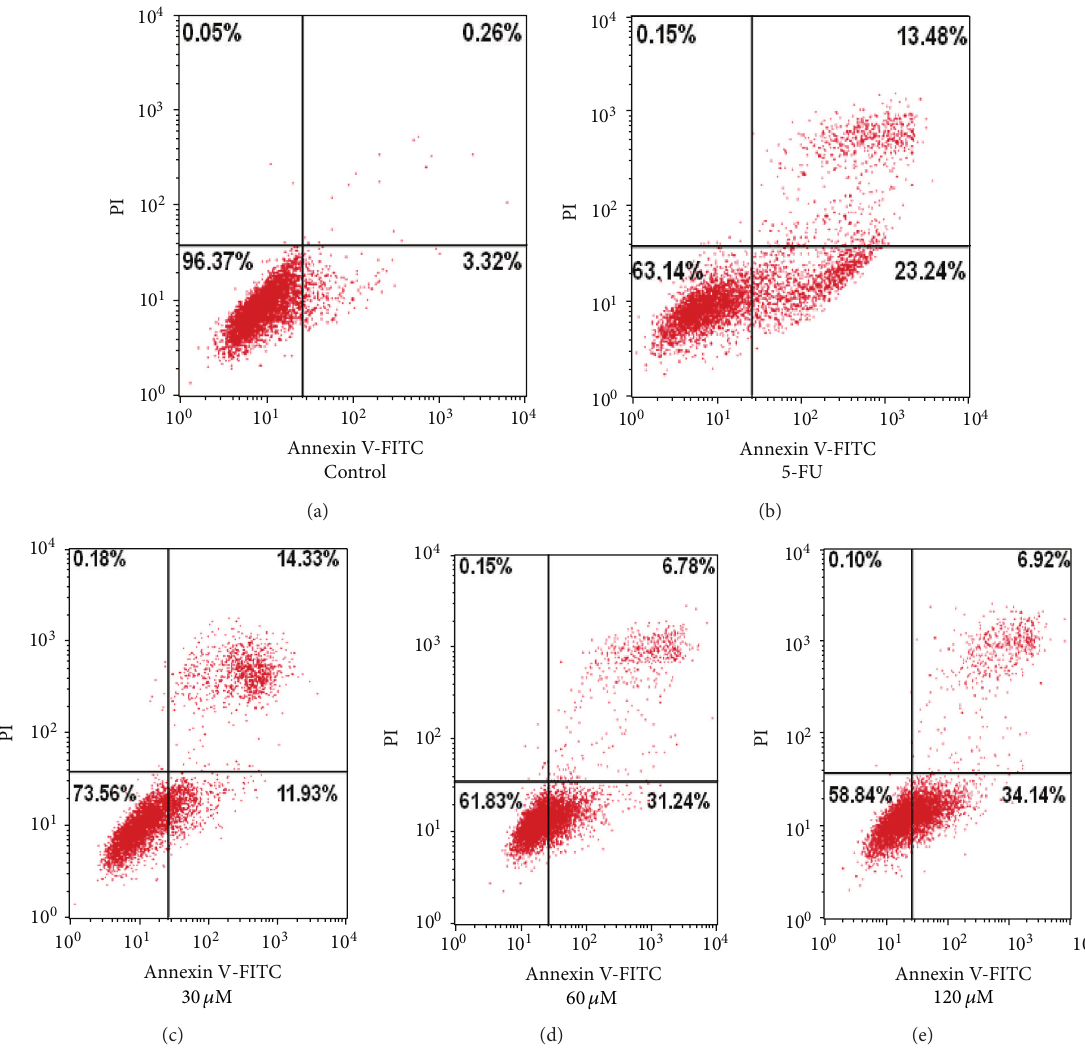
Figure 10: Distribution map of cell apoptosis. BEL-7402 cells were incubated with different concentrations of the complex 2 (30, 60, and 120 𝜇 M) for 48h, subjected to Annexin V-FITC/PI staining, and analyzed by flow